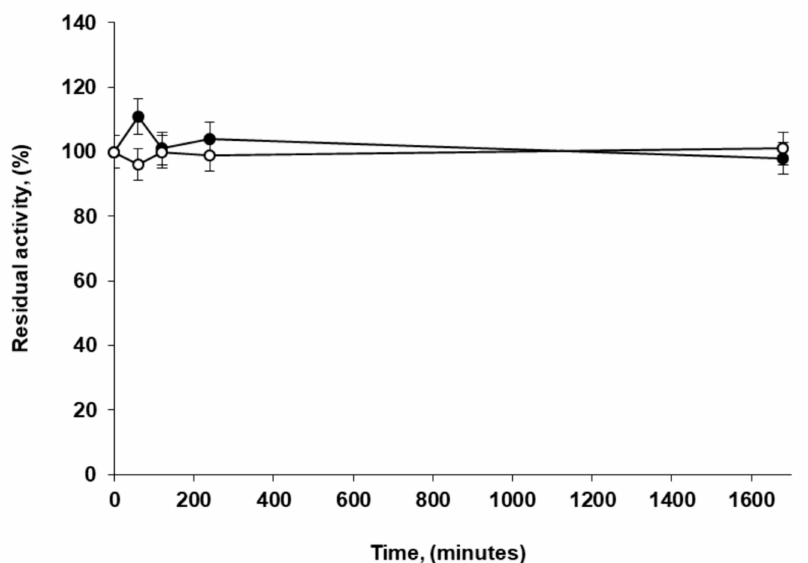
Figure 5. E ff ect of the incubation in 4% Triton X-100 on the activity of glyoxyl-octyl-PFL biocatalyst. The lipase preparation was incubated in 4% ( v / v ) of Triton X-100 at pH 7 and 25 ◦ C. Experiments were performed as described in Methods. Empty circles: glyoxyl-octyl-PFL (control); solid circles: glyoxyl-octyl-PFL in presence of Triton X-100.